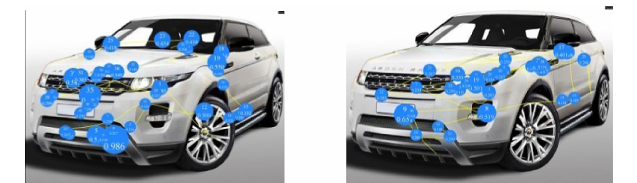
Figure 3. Individual gaze track for one user (free interaction vs. dynamic).